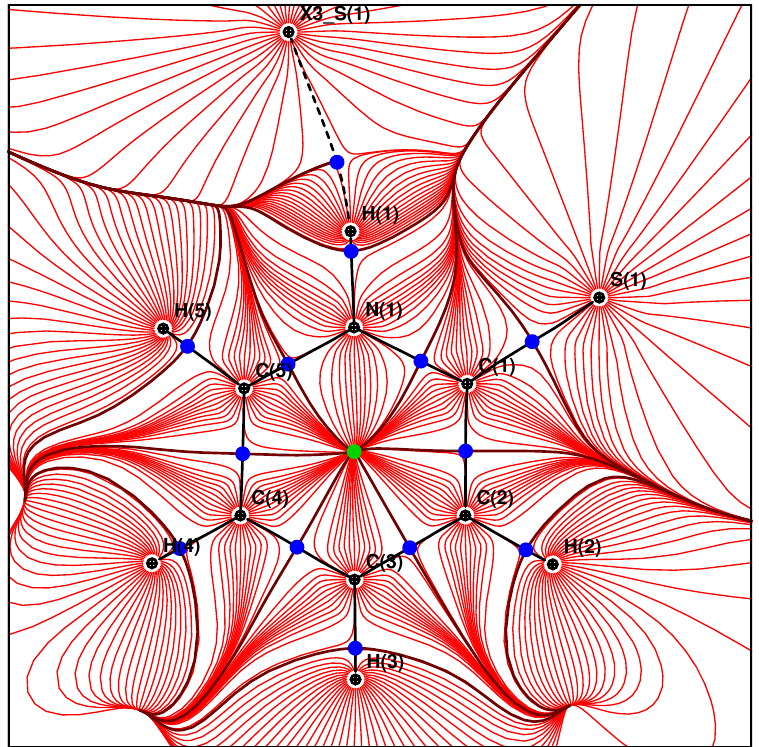
Figure 9. Trajectory plot of the electron density in (I) from the final multipole refinement. (3, − 1) Crit- ical points are drawn as blue circles and the (3, +1) critical point as a green circle. The intermolecular N–H · · · S hydrogen bond is drawn with dashed lines. The drawing was created with the module XDPROP of the XD software